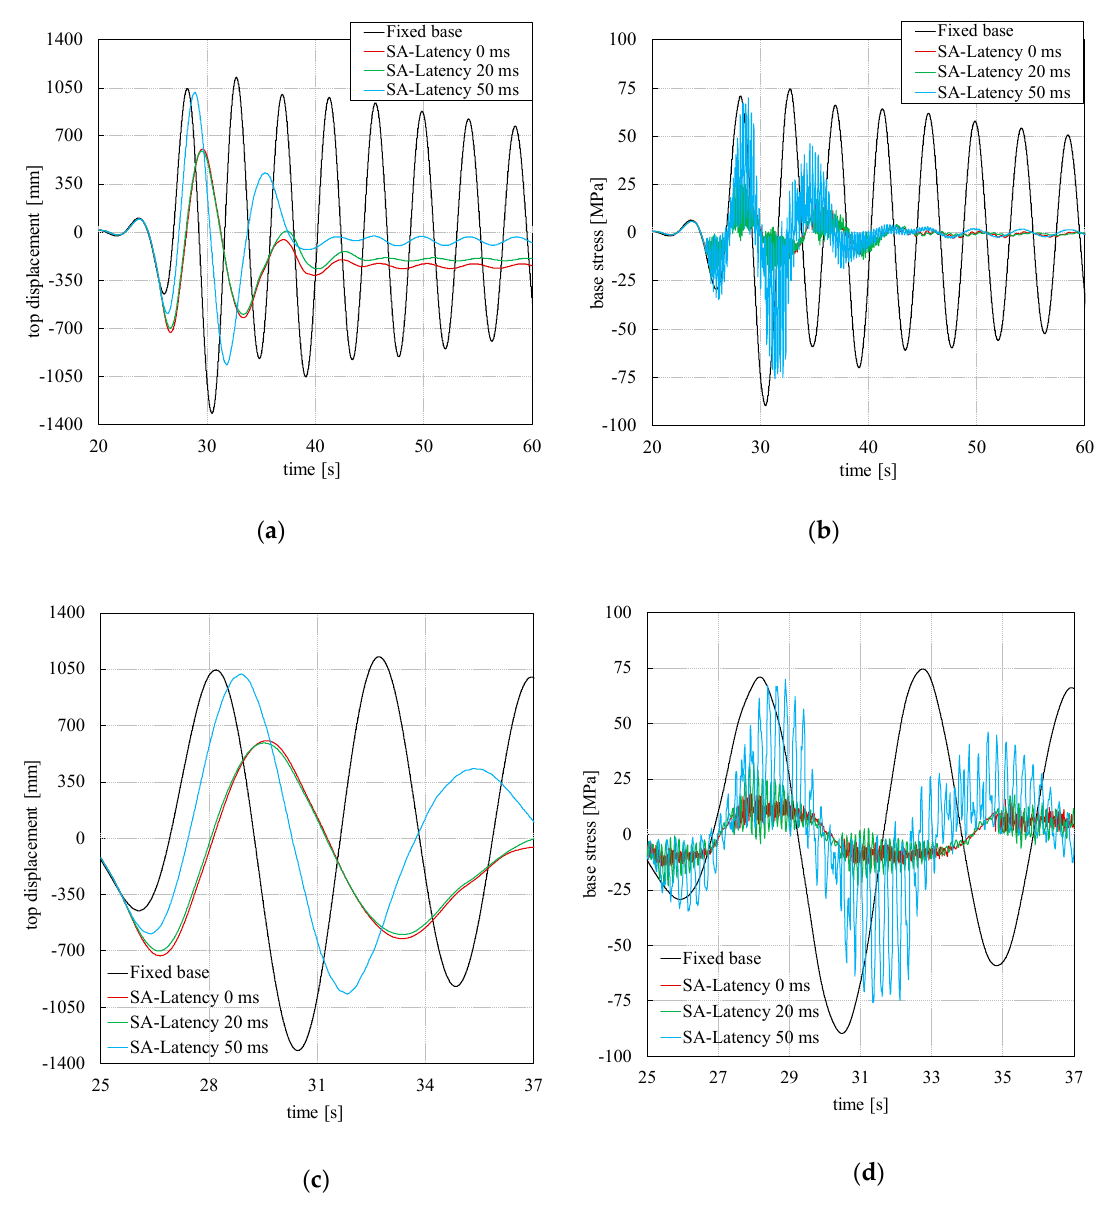
Figure 8. ( a ) Displacement and ( b ) stress response for different latencies of measures for control, ( c ) zoom of panel (a), ( d ) zoom of panel (b). Table 6. Range of demand reduction against the three load cases for the range 10–100 ms of latency in measurements for control.